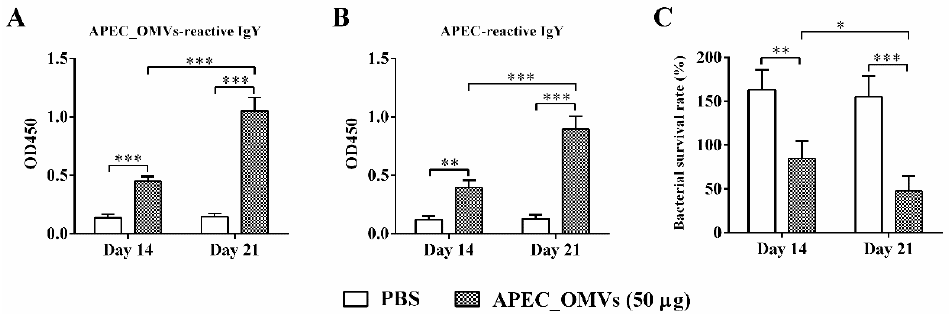
Figure 7. Specific IgY levels and bactericidal activities of serum samples from APEC_OMV-immunized chicks. Serum samples were collected from PBS- and APEC_OMV (50 µ g)-immunized chicks at 14 and 21 days of age (one week after primary and secondary vaccination, respectively) before the secondary APEC_OMV vaccination or bacterial challenge. The production of APEC_OMV-reactive IgY ( A ) and APEC-reactive IgY ( B ) was estimated by ELISA assays. ( C ) Bacteria killing assay by the APEC_OMV-immunized serum. The APEC O2 strain was incubated with PBS- and APEC_OMV (50 µ g)-immunized serum samples at 37 ◦ C for 1 h and then the bacterial survival rate was measured. Data are presented as mean ± SE (n = 6). * p < 0.05; ** p < 0.01; *** p < 0.001.